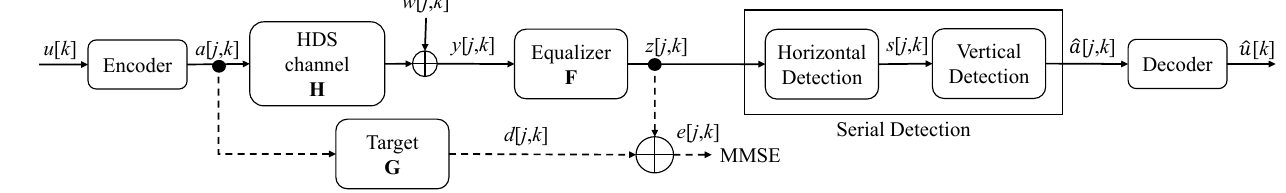
Figure 3. Proposed simulation